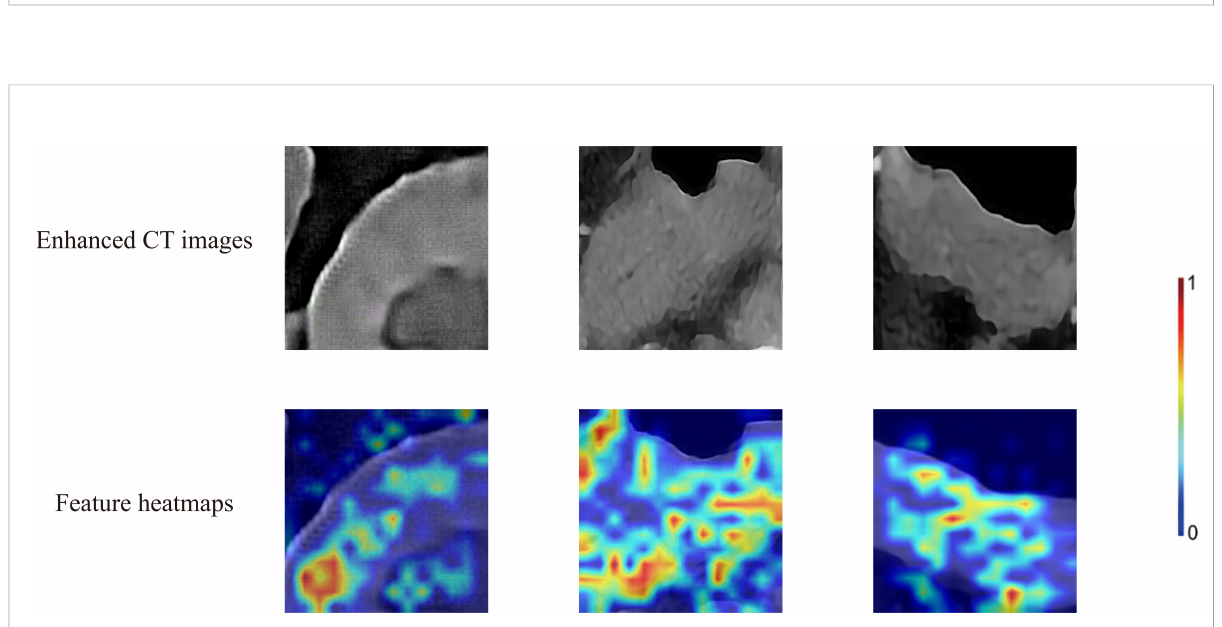
FIGURE 5 Enhanced CT arterial phase images and feature heatmaps generated by VIT. The importance of features is represented by color